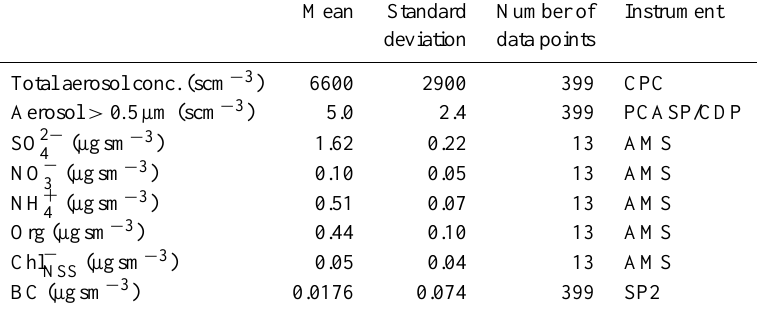
Figure 4. Overview of in situ cloud measurements made on 3 August 2014. Panel (a) shows calculated precipitation from the UK operational radar network at several points during the afternoon. The blue dashed lines are axes AB and CD, and the black line is the flight track of the BAe-146 5min either side of the time for each panel. The black arrow shows the wind direction. Panels (b) and (c) show time series of the altitude and sampling focus of the two aircraft. The listed times are in UTC, and the local time was UTC + 1. Table 1. Mean and standard deviation of aerosol number and composition during a run along the peninsula at 570m, between 11:52:14 and 11:58:53UTC. The AMS chloride measurement (Chl − ) does not include sea salt, so the total chloride concentration is likely to have NSS been higher. The s preceding the concentration units denotes that the data are corrected to standard temperature and pressure (273.15K and 1013.25hPa. Mean Standard Number